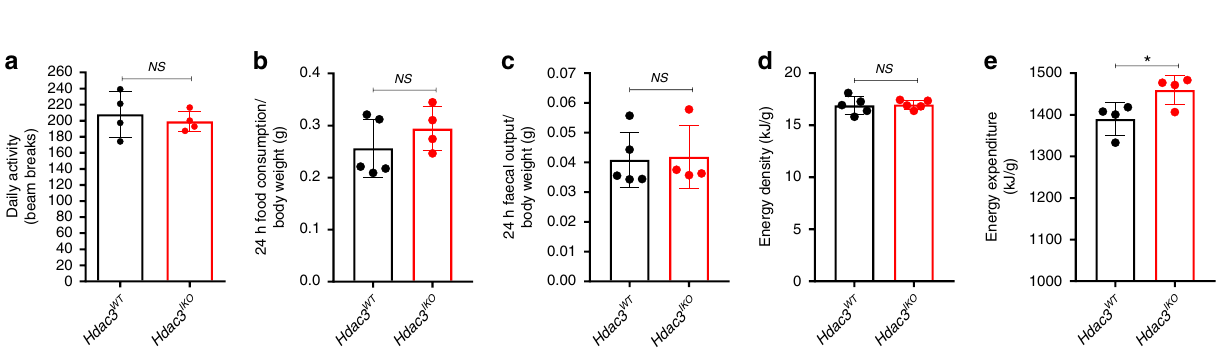
Fig. 2 Reduced adiposity is not due to altered activity, food intake, faecal output or malabsorption. a Daily spontaneous physical activity, ( b ) food consumption, ( c ) faecal output and ( d , e ) energy content of stool in Hdac3 WT and Hdac3 IKO mice. a Spontaneous physical activity was monitored in 4 – 8- week-old male mice individually housed for 3 days and fed a standard chow diet. b , c Food consumption and faecal output measured in 4 – 8-week-old individually housed male mice over 5 consecutive days, and fed a standard chow diet. In all cases, values shown are the mean ± SEM of n = 4 ( a , b , e ) or n = 5 ( c , d ) mice per genotype. * P < 0.05, NS not signi fi cant, unpaired t